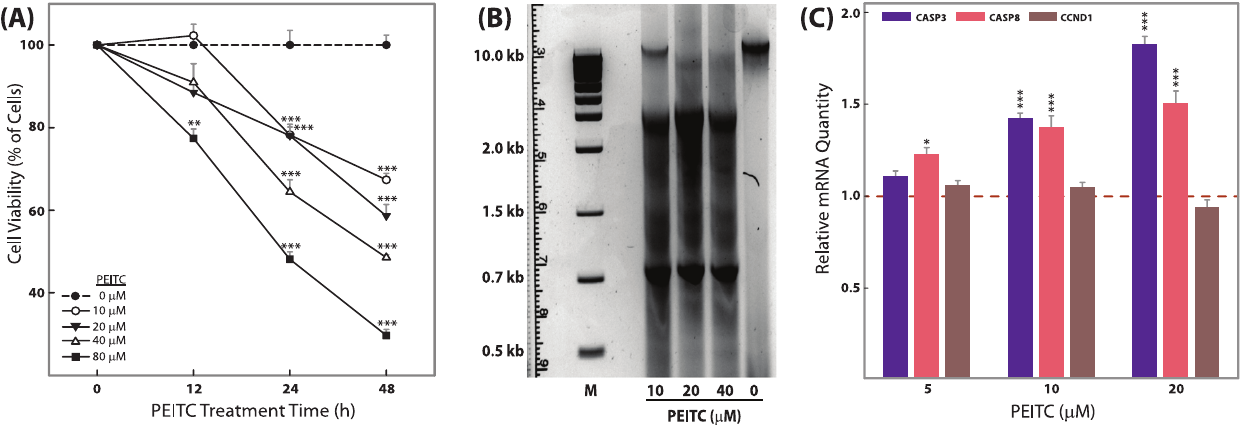
Figure 1. Time- and concentration-dependent effects of PEITC on SW480 cell proliferation. Following 12, 24, and 48 h PEITC exposure and a subsequent 2 h incubation with CellTiter aqueous reagent (Promega), A 490 nm was measured in SW480 cells in a BioTek Synergy H4 reader. Percentage cell viability is shown relative to control (no PEITC) as the mean 6 SEM (A); Concentration-dependent effects of PEITC at 48 h on DNA fragmentation (B); Concentration-dependent modulation of the expression of genes related to apoptosis and the cell cycle by PEITC at 48 h. GAPDH was used as a housekeeping control for relative quantification of gene expression changes (C); for all experiments n=3. *p , 0.05, **p , 0.01, ***p , 0.001. No loss in cell viability in the 10 m M PEITC group compared with the no-PEITC group was observed up to 12 h.